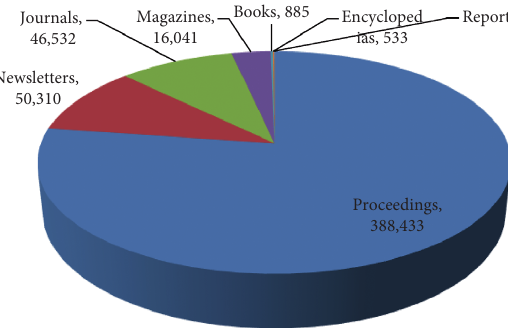
Figure 5: All publication and number of papers.